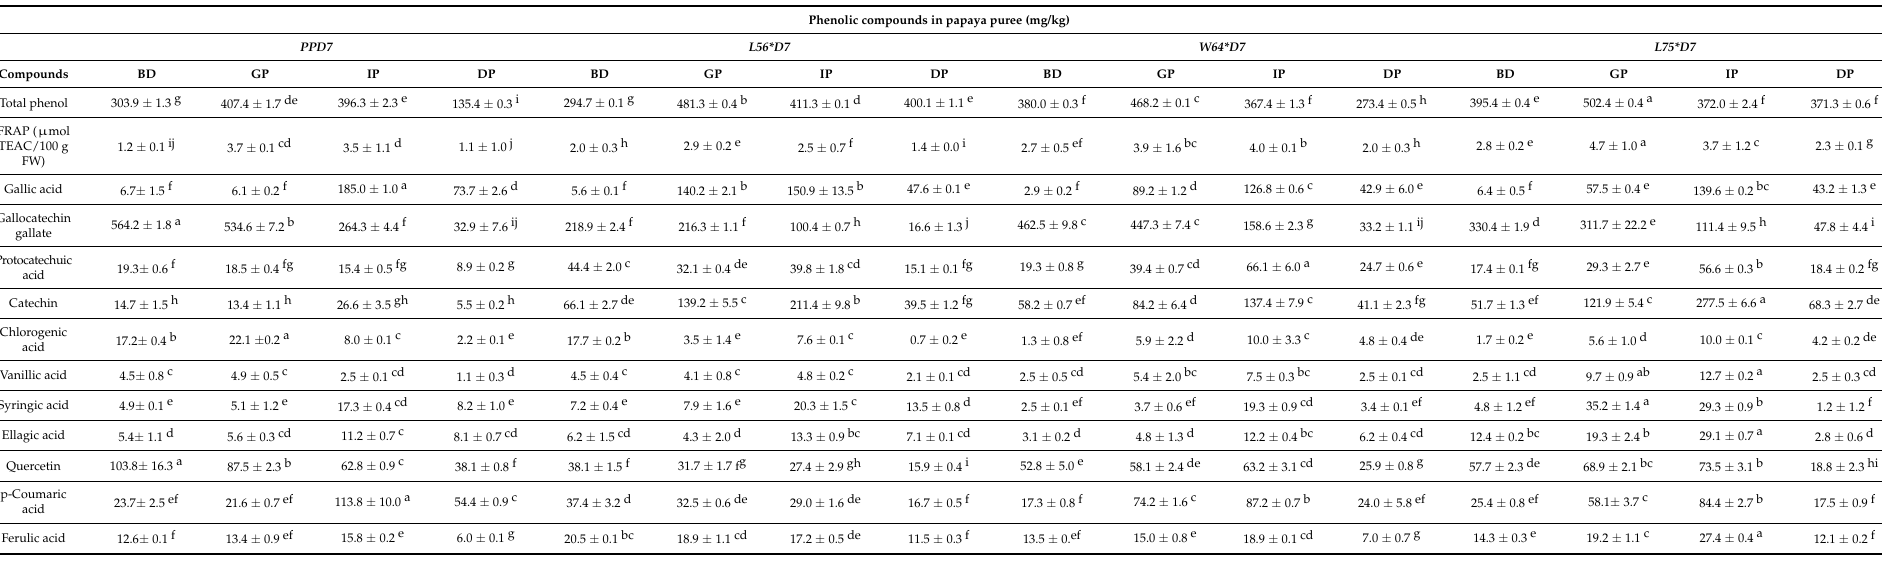
Table 4. Influence of fermentation on simulated in vitro gastrointestinal digestion of different phenolic compounds in papaya puree (mg/kg)